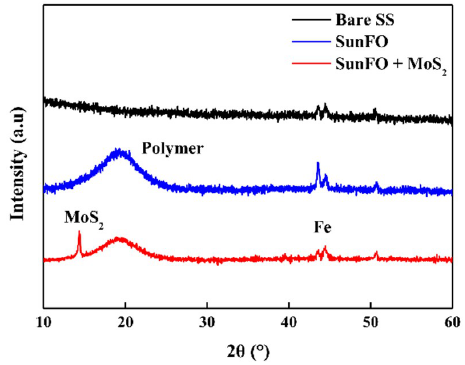
Figure 5. XRD results of ( a ) Bare SS; ( b ) SunFO coated SS; ( c ) SunFO with MoS 2 coated SS.